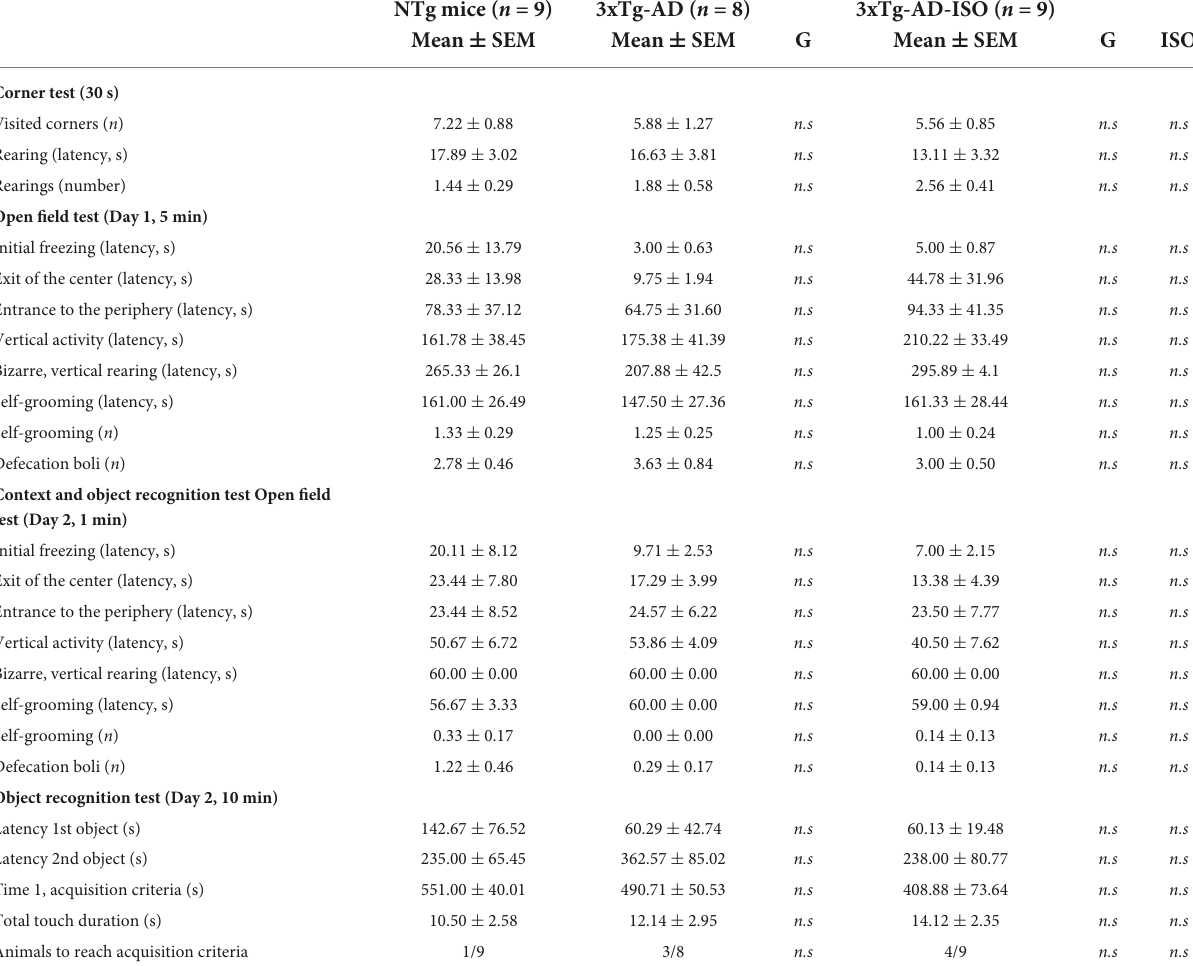
TABLE 1 Convergence of 18-month-old NTg and 3xTg-AD females’ phenotypes in the corner test, open field test and object recognition test. NTg mice ( n =